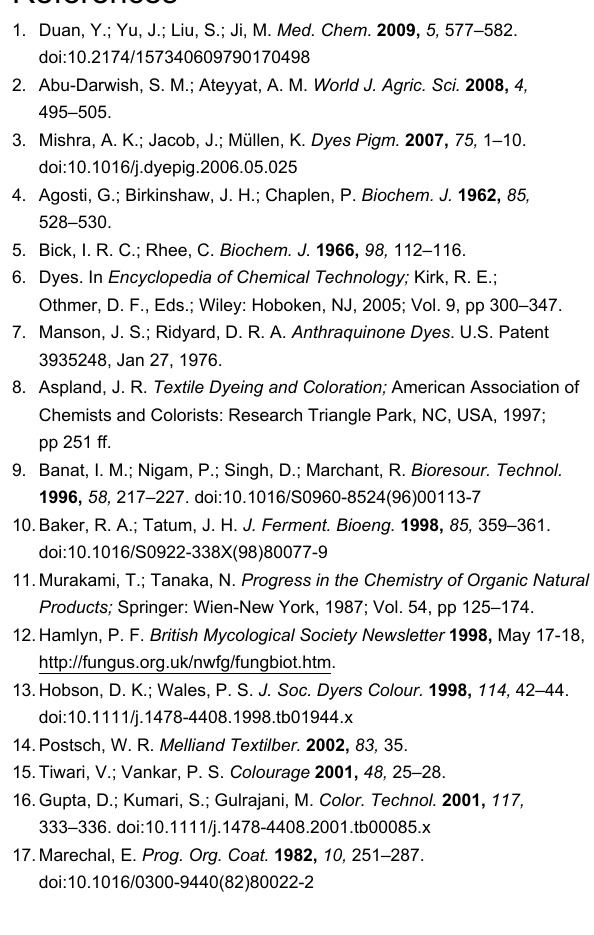
Figure 5: Broad spectrum of colors, created by mixing of green 2 , blue 6 and red 15 .